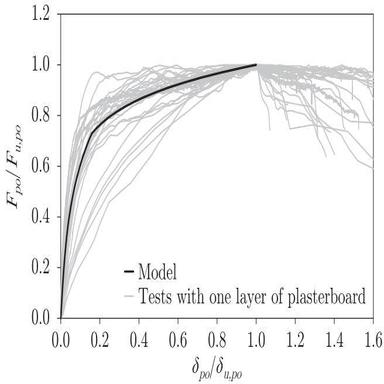
Comparison between the proposed load-slip model and normalised test curves for specimens with one layer of plasterboard.